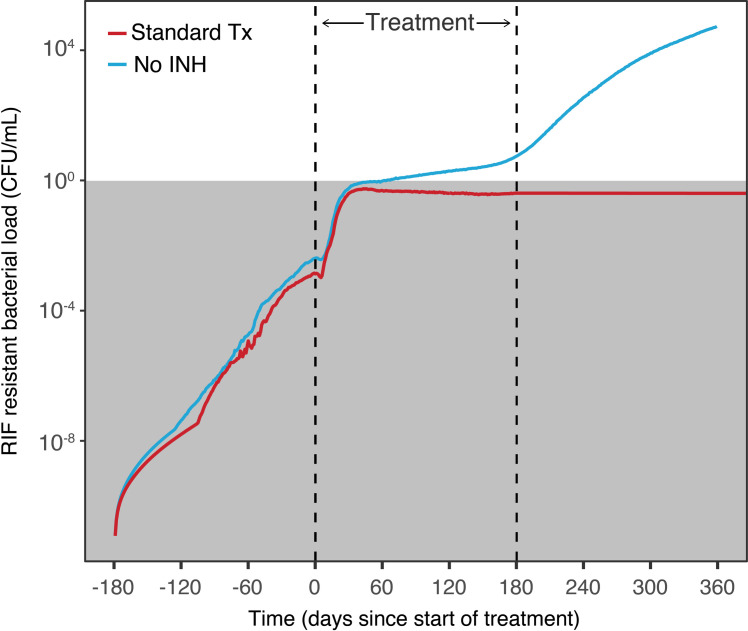
Faster growth of drug-resistant bacterial strains due to incomplete drug therapy.Comparison of growth of rifampin mono-resistant bacterial strain during treatment of TB infection, with standard drug therapy (2HREZ/4HR) vs. therapy excluding isoniazid. Based on simulation of 5000 patients. Infection occurs on day -180, and drug therapy is started on day 0.